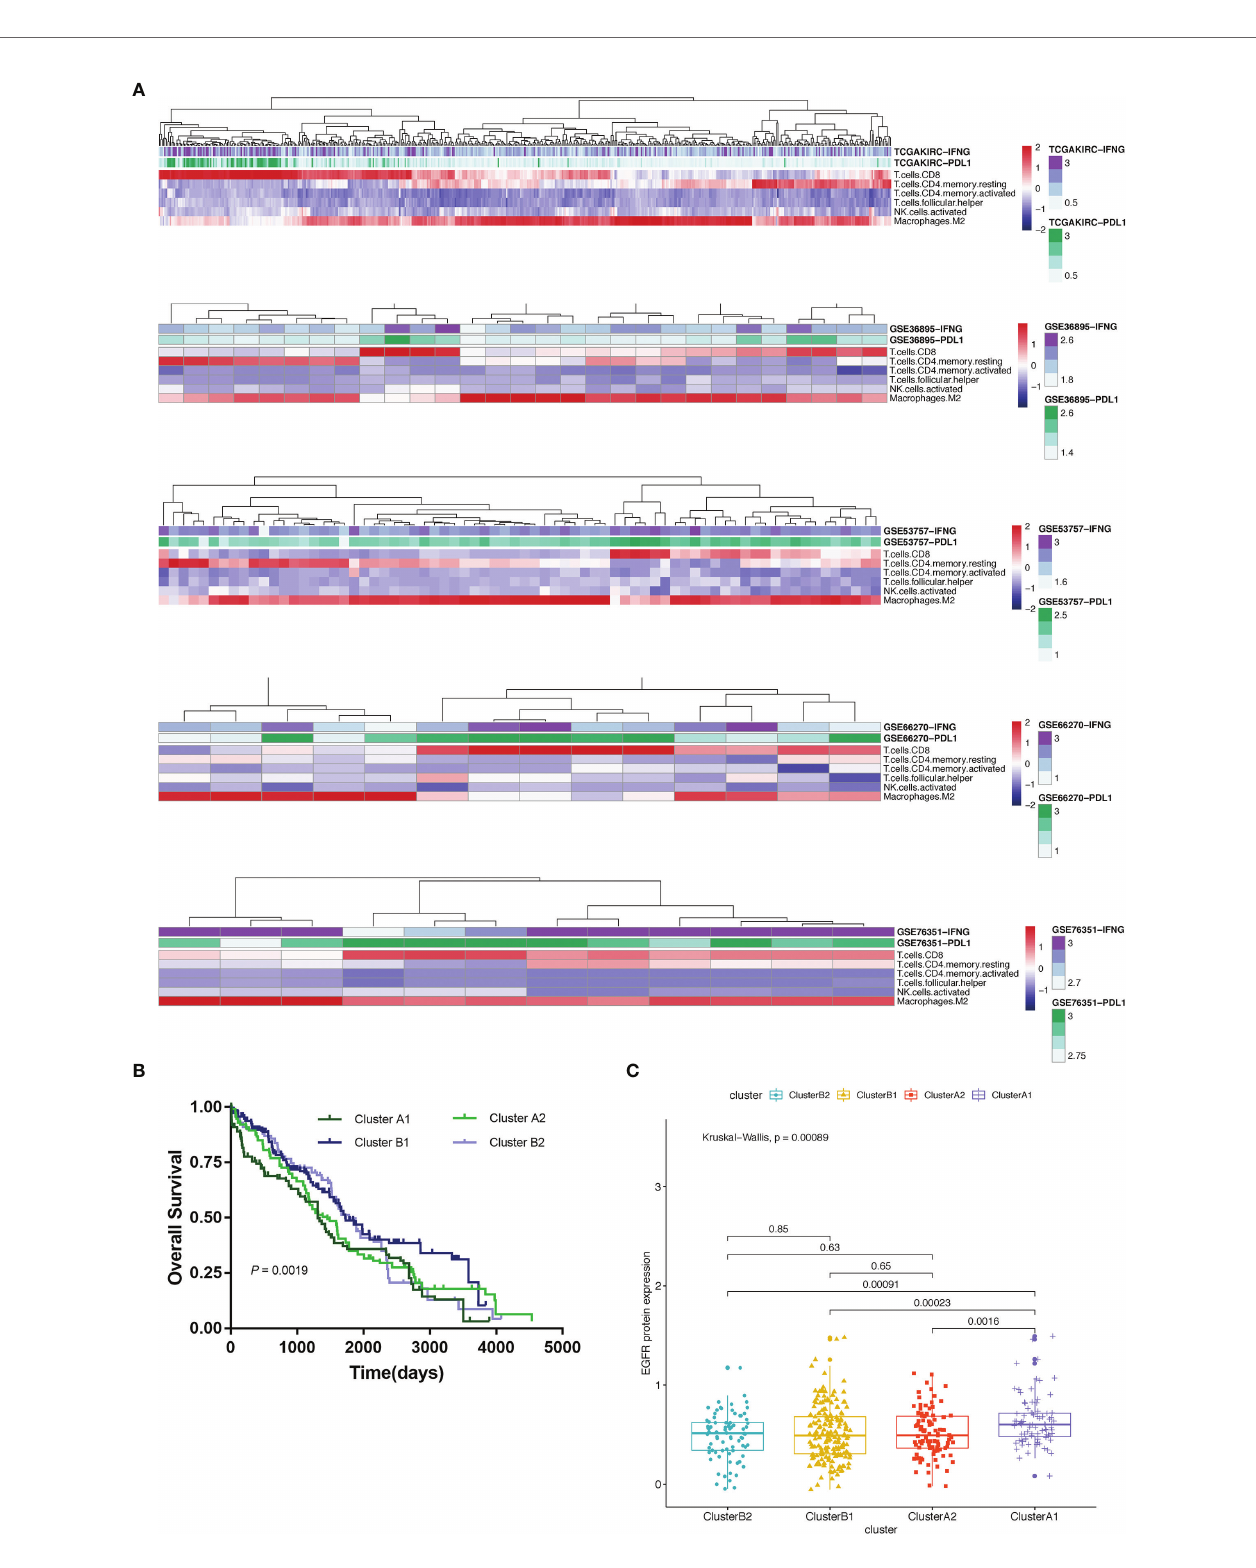
FIGURE 3 | (A) Heat map depicting unsupervised clustering of cohorts from the GEO and TCGA-KIRC based on the contents of 6 kinds immune cells. (B) Overall survival of 4 immune clusters. (C) A boxplot showing expression levels of EGFR among 4 immune